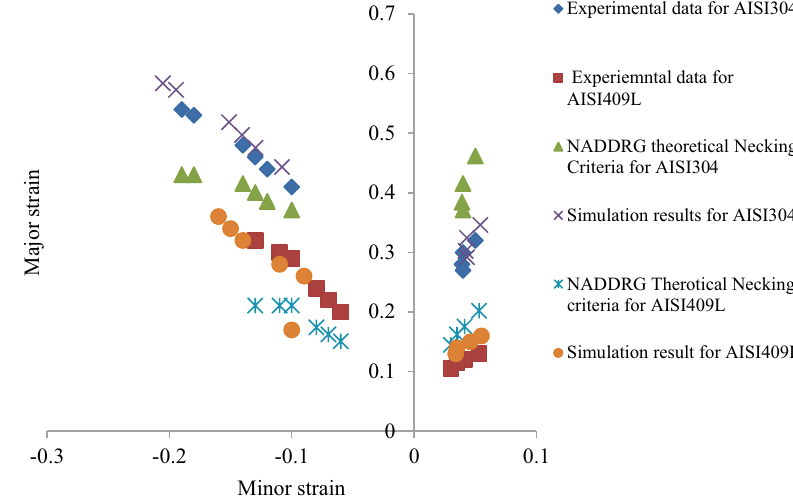
Fig. 11 Theoretical, numerical and experimental forming limit diagram (FLD)